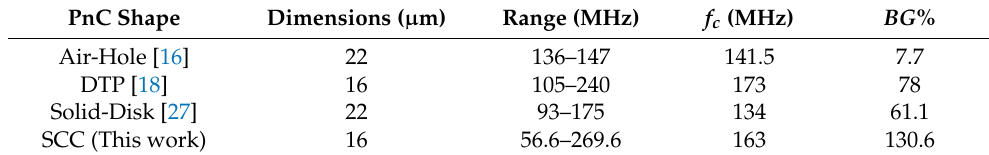
Figure 3. ( a ) Traditional PnC dispersion curve ( b ) Vibration mode diagram of the start and end points of the band gap (The arrow represents the size and direction of the displacement). Table 2. Comparison of simulated BG% between various PnC shapes using a similar lattice